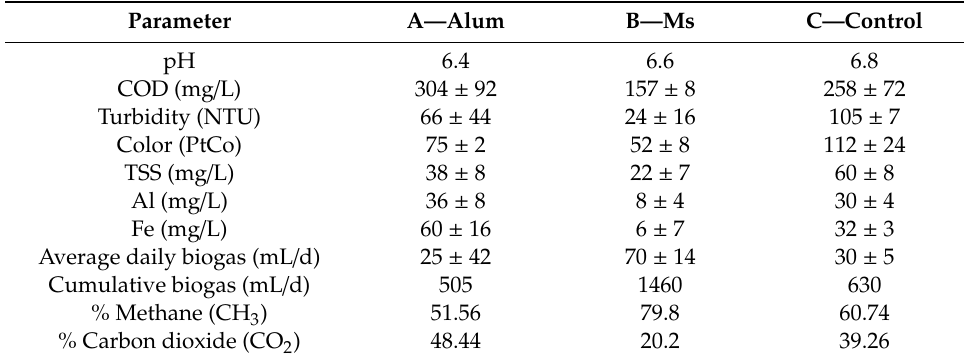
Table 4. Summarized results of the BMP